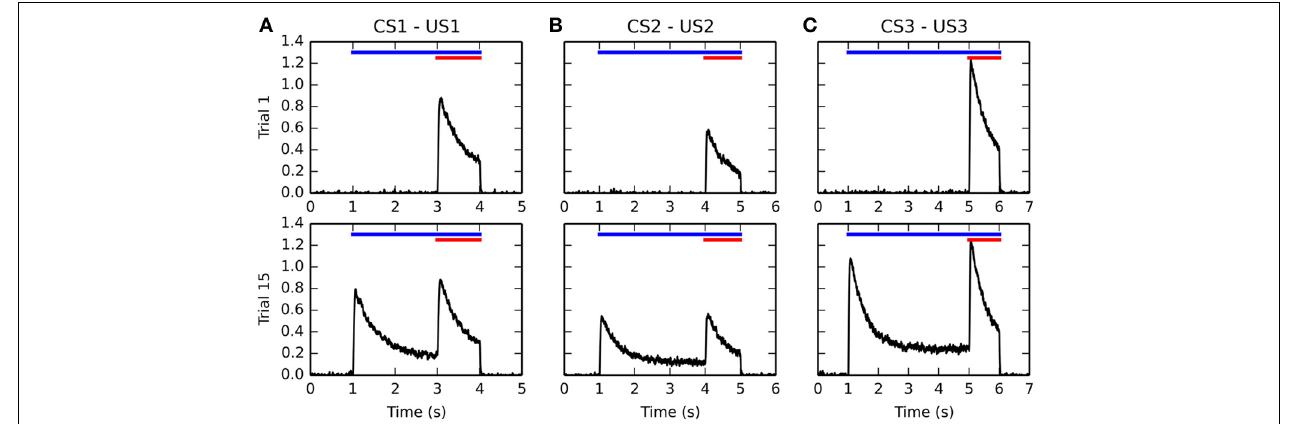
FIGURE 4 | Timecourse of the activity of different BLA cells before and after conditioning. Activities for the CS1-US1, CS2-US2, and CS3-US3 associations are represented from left to right in panels (A–C) , respectively. For each figure, the horizontal blue line represents the presentation of the CS, while the red line represents the presentation of the US. The top row shows the evolution of the firing rate of a single BLA neuron over time during the first trial of conditioning. Because of the sensitization phase and the lateral inhibition in BLA, there is only one cell in the population which represents each US. During the first trial, this cell gets maximally activated at the time of